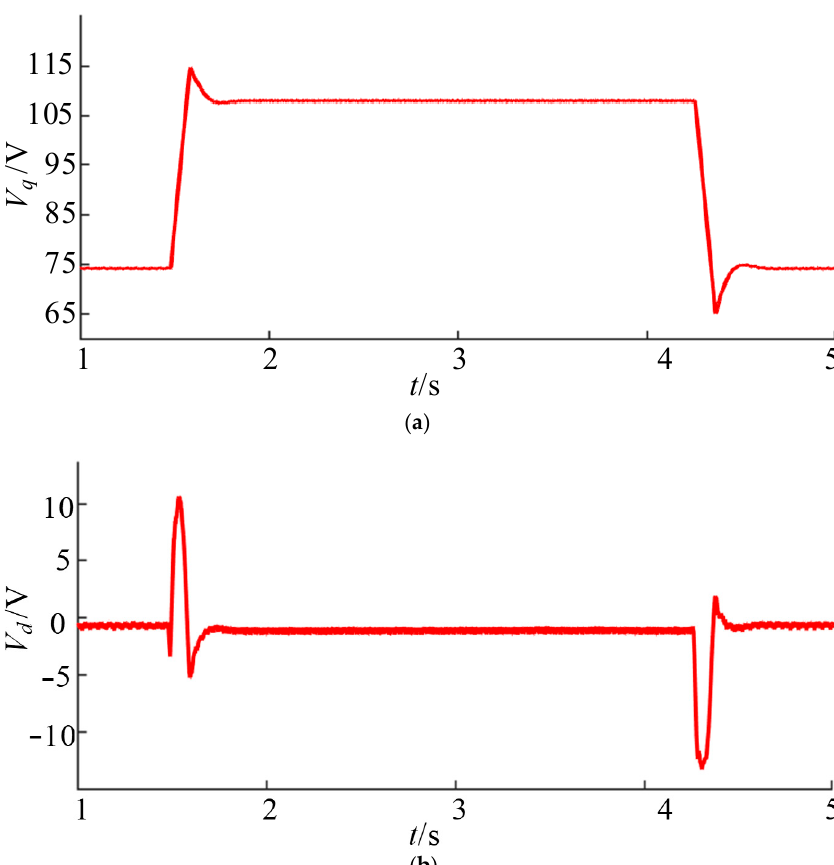
Figure 7. Distributions of the speed mutation. ( a ) Experimental curve of the speed. ( b ) Experi- mental curve of the rotational speed error.